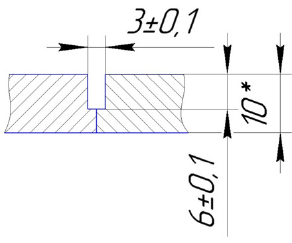
Figure 3. Geometric dimensions of the samples before